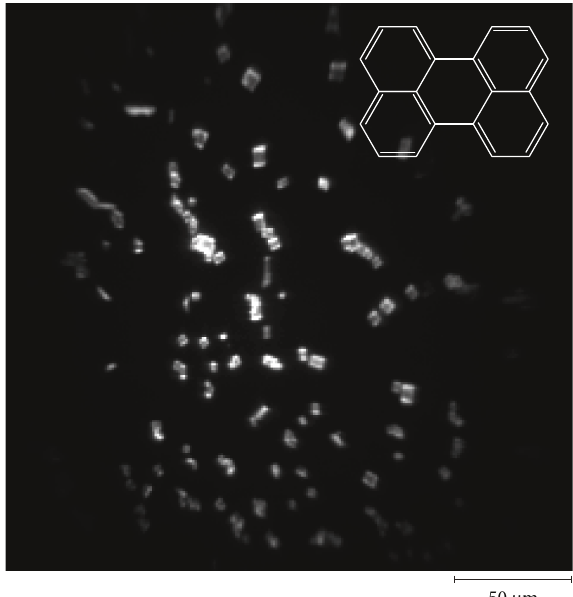
Figure 4: Fluorescence microscope image of the perylene microcrystals on the glass substrate. Micron-sized crystals dispersed on the substrate were observed. Inset: chemical structure of